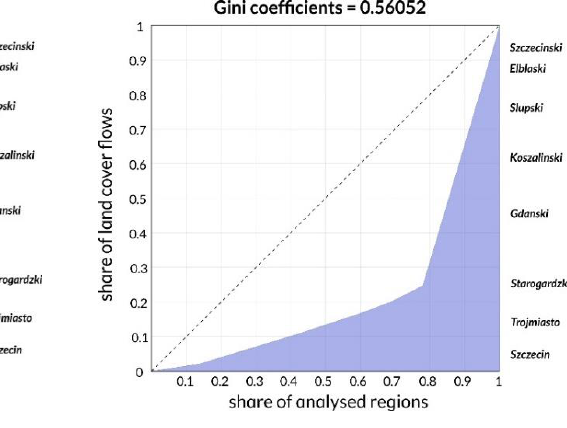
Figure 10 . Choropleth map of LCF2 and LCF4 in percent. Along with the intensification of agriculture, changes in forest cover were noted, as the highest land cover flow in the Polish Baltic coastal zone (Table 6). The largest afforestation was noted in the Slupski, Elblaski, and Koszalinski regions, where the intensification of agriculture could be observed at the same time (Figures 10 and 11a).